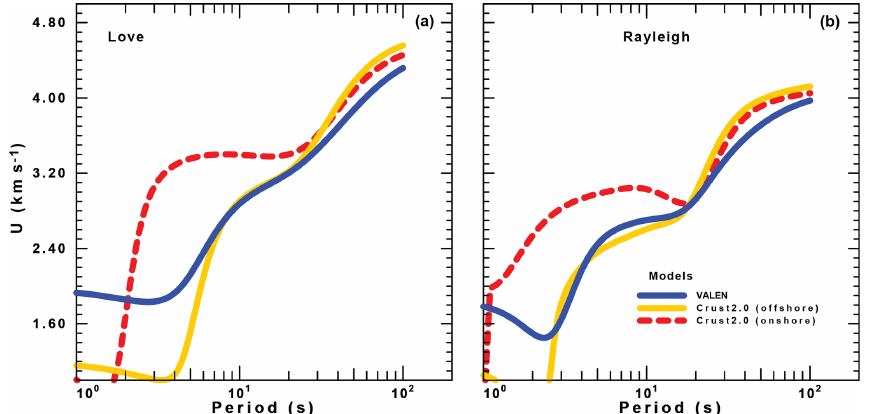
Figure 3. Predicted group velocities for different models discussed in the text. VALEN is the model used for waveform inversion, CRUST2.0 offshore is the grid point of CRUST2.0 closest to the CASTOR UGS, and CRUST2.0 onshore is the grid point immediately to the west, located in the eastern Iberian Peninsula. Love-wave group velocities are shown in (a) and Rayleigh-wave group velocities in (b)